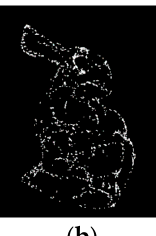
Figure 4. The pyramid of scale-keeping simplification entropy: ( a ) the multi-layer pyramid; ( b ) the view of point SIFT elements in different layers.